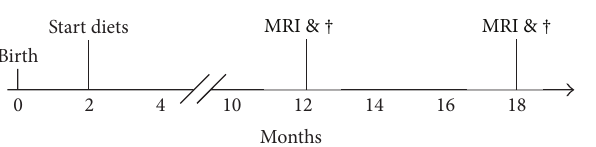
Figure 1: Timeline of experimental design. Starting from 2 months of age, mice were randomly divided into two groups; animals were fed either with control diet or with Fortasyn diet. The first group of mice underwent MR imaging (MRI) at 11 to 12 months of age and were sacrificed ( † ) immediately thereafter. The second group was sacrificed after MRI at 18 months of